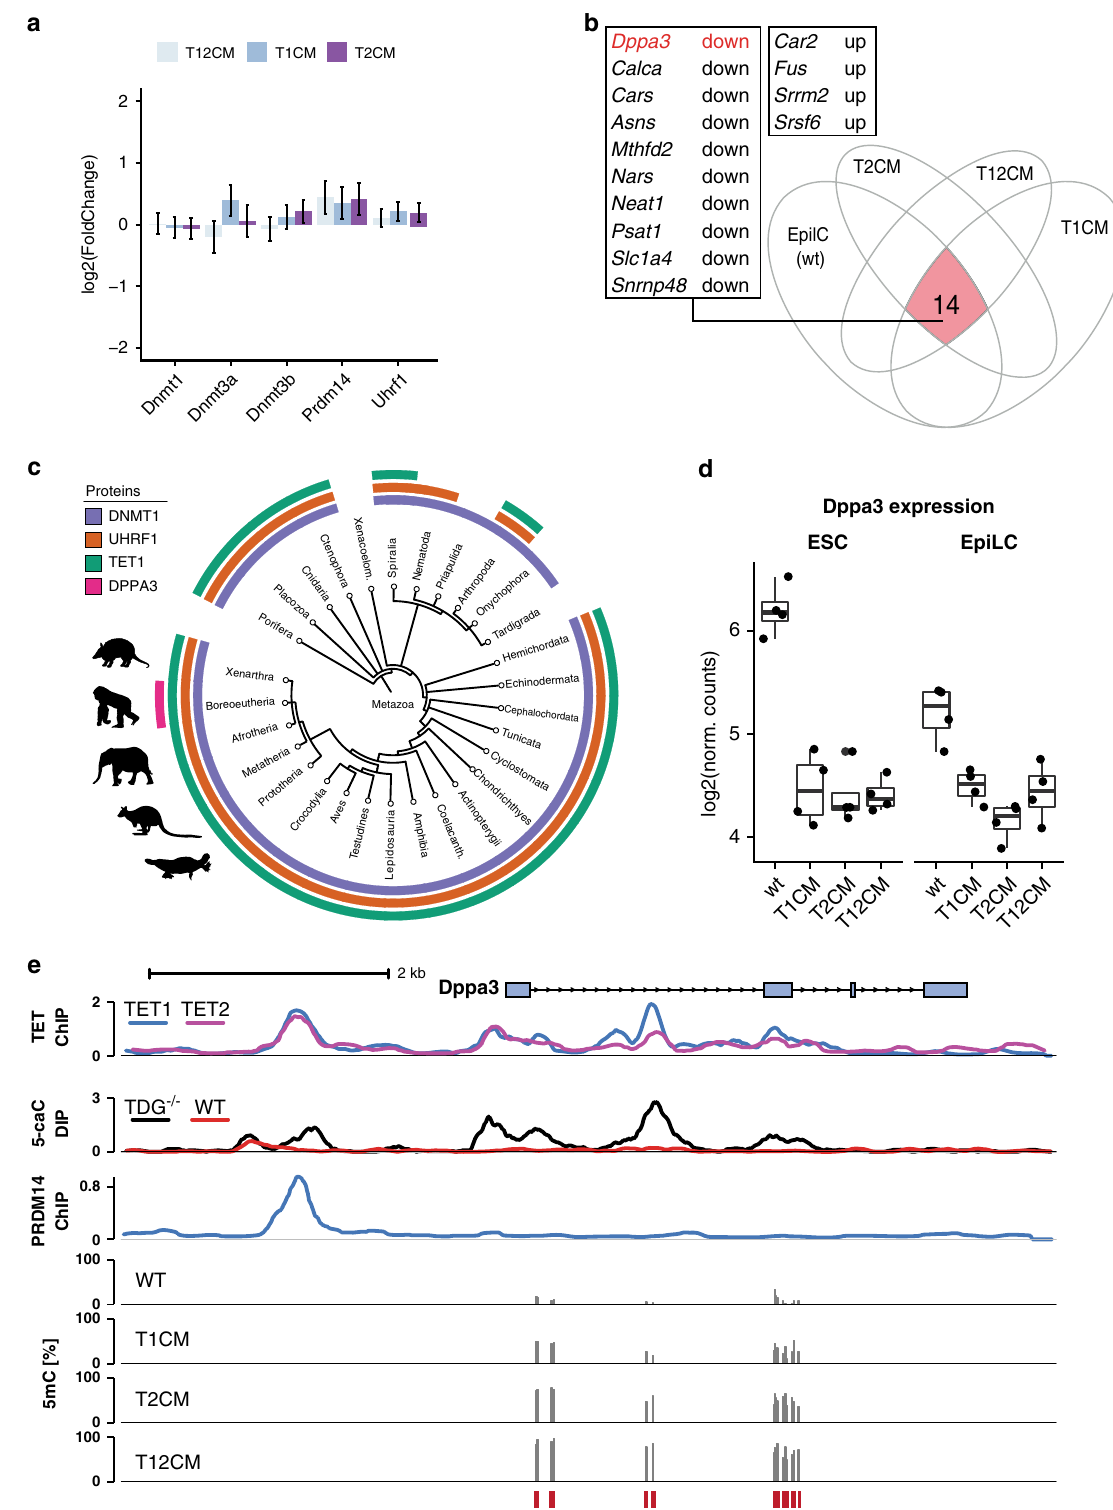
In addition, Dppa3 is also a direct target of PRDM14, a PR domain-containing transcriptional regulator known to promote the DNA hypomethylation associated with naïve pluripotency 50,70 – 72 (Fig. 2e). PRDM14 has been shown to recruit TET1 and TET2 to sites of active demethylation and establish global hypomethylation in naïve pluripotency 50,54,71 – 73 . As the expression of Prdm14 was not altered in Tet catalytic mutant ESCs (Fig. 2a), we analyzed